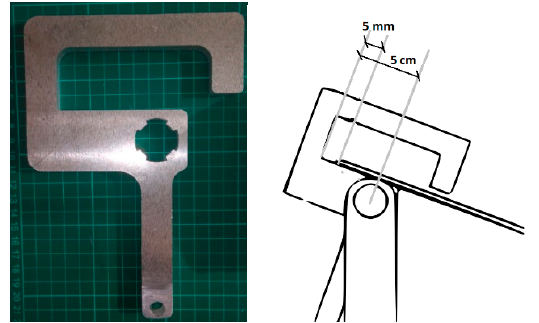
Figure 14. Final clamp and safety distance from the mirror to the clamp. Clamp that supports the mirrors for bending with the system shown in Figure 13.